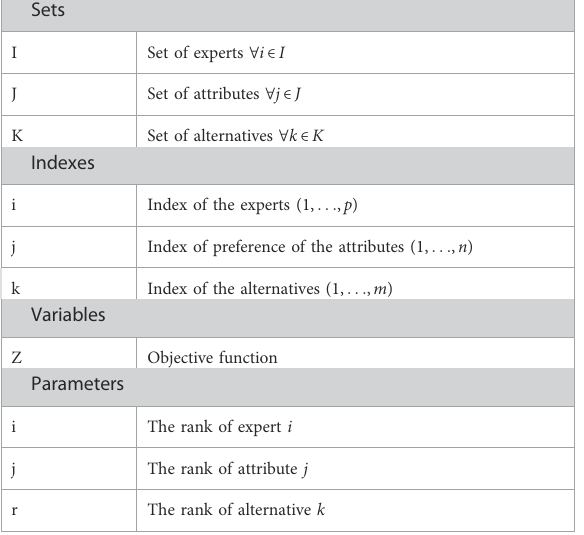
TABLE 2 The components of OPA (Source: Author).